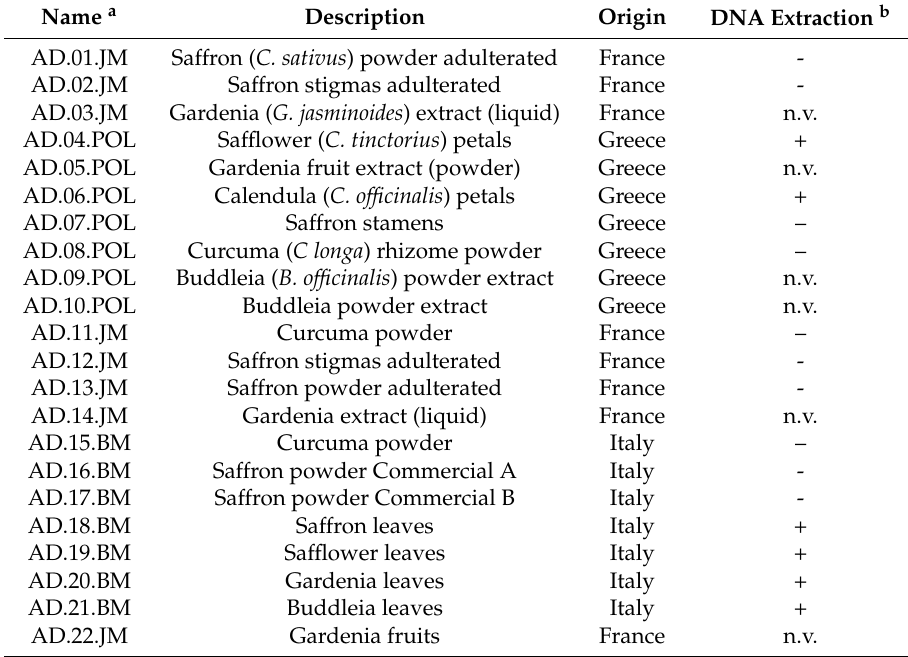
Table 1. The samples considered for the setup of the DNA extraction methods and the development of the informative markers are listed. Visually, the three methods provided the same results in terms of amount and integrity of recovered